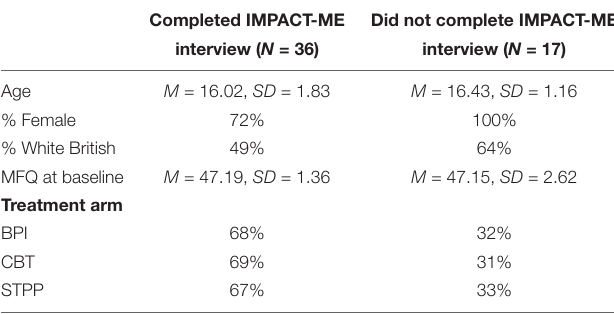
FIGURE 1 | Time 2 refers to the Experience of therapy interview with adolescent (conducted after therapy ended); Time 3 refers to the Thinking back about therapy interview with adolescent (conducted one year after the end of therapy); Complete dataset refers to the adolescent completing a Time 2 and Time 3 interview and their therapist also completing a post-therapy interview. TABLE 1 | Descriptive statistics for those who dropped out of therapy and did or did not participate in the IMPACT-ME